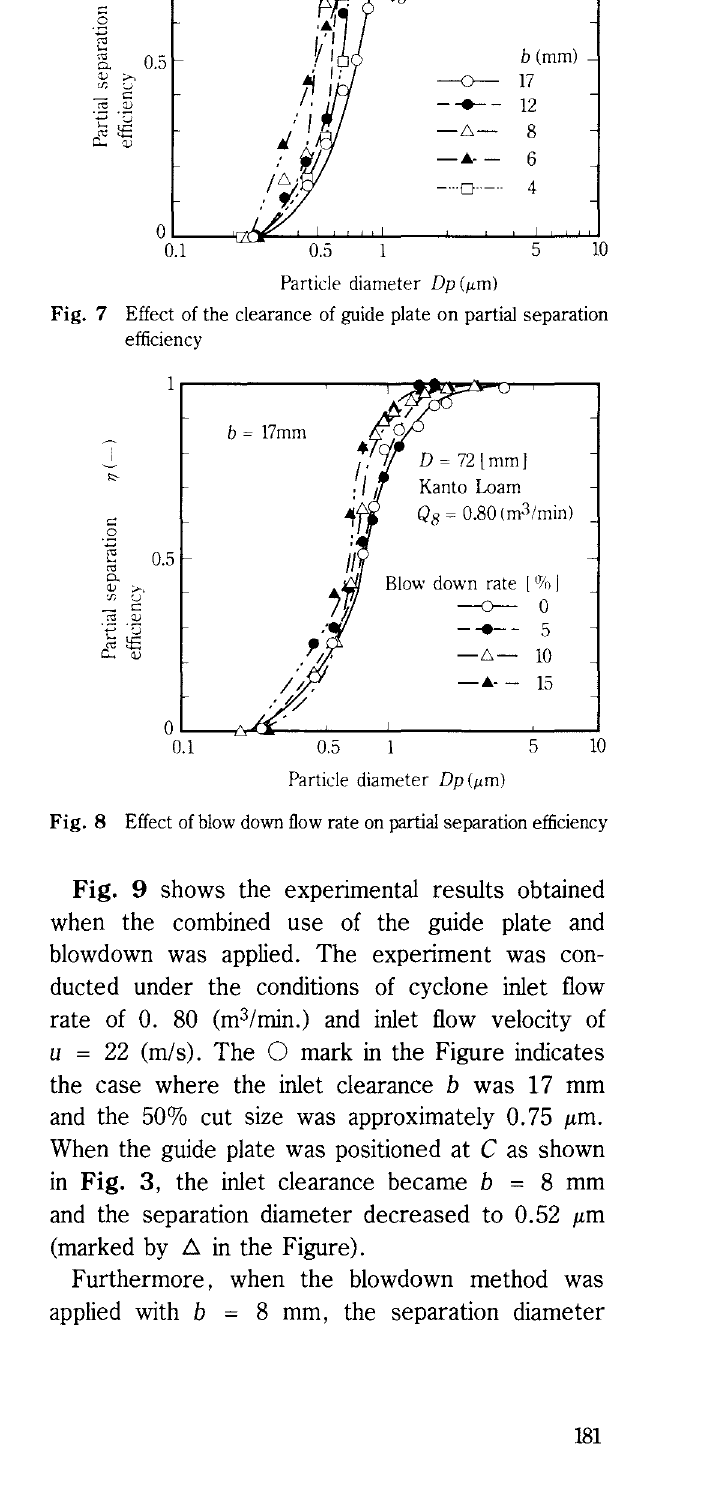
Fig. 7 Effect of the clearance of guide plate on partial separation efficiency